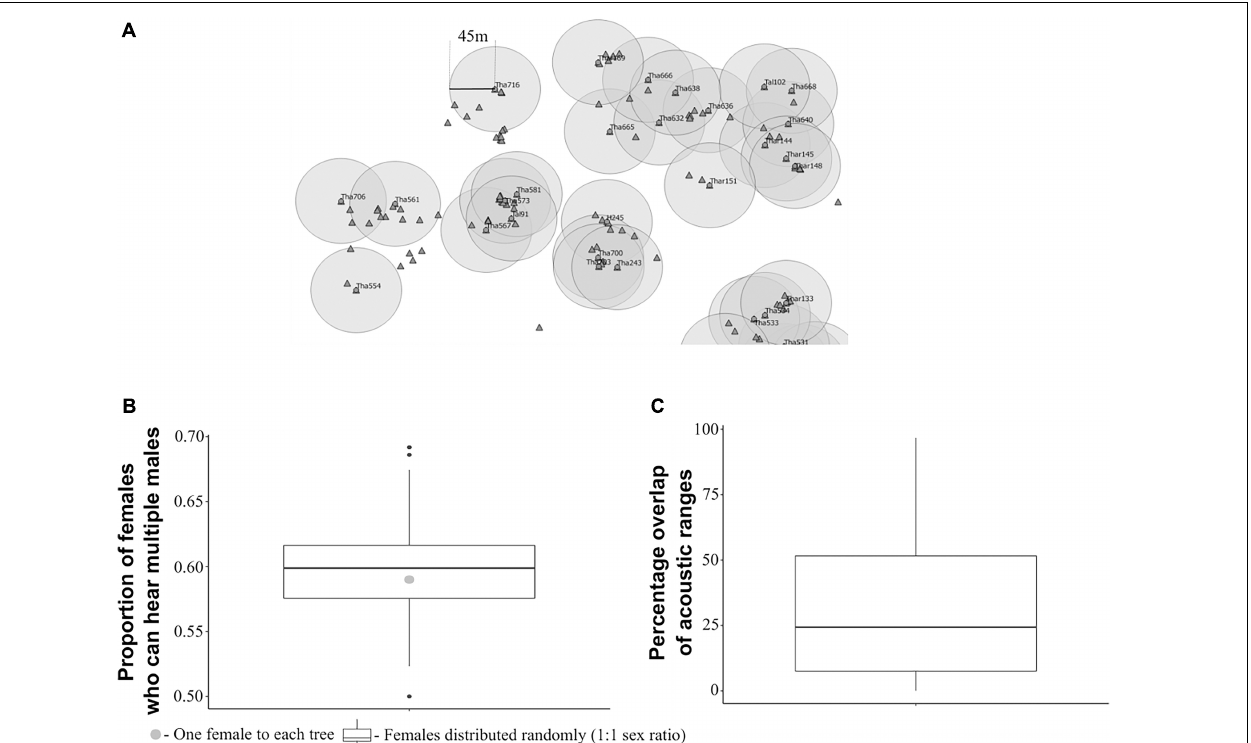
FIGURE 3 | Acoustic environment of calling males and females. (A) Figure depicting the acoustic ranges of a small sample of callers (taken from the spatial map of callers), with the callers (circles) as the centres of circles, the radius of which is defined by the distance at which the average SPL of the male’s call drops to the female hearing threshold. Triangles indicate assumed locations of individual females, where females are assumed to be one per each tree. (B) Proportion of females that could potentially hear more than one male (apart from the male on their tree) under the two assumptions: (1) One female to each tree (n females = 773, n males = 172), (2) Females randomly distributed on trees (n females = 172, n males = 172); (C) Percentage overlap in acoustic ranges of males (n = 172).